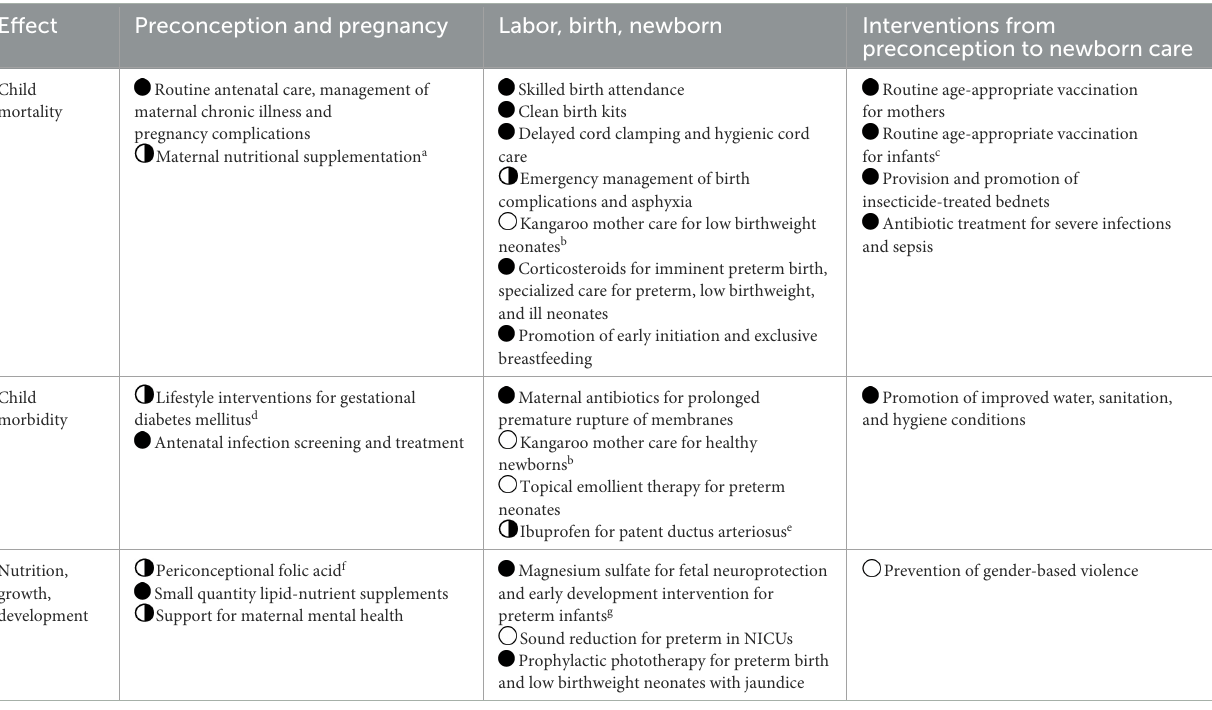
TABLE 1 Provision and coverage of evidence-based interventions provided as part of routine care at SMRU clinics for refugees and migrants, adapted from Vaivada et al.